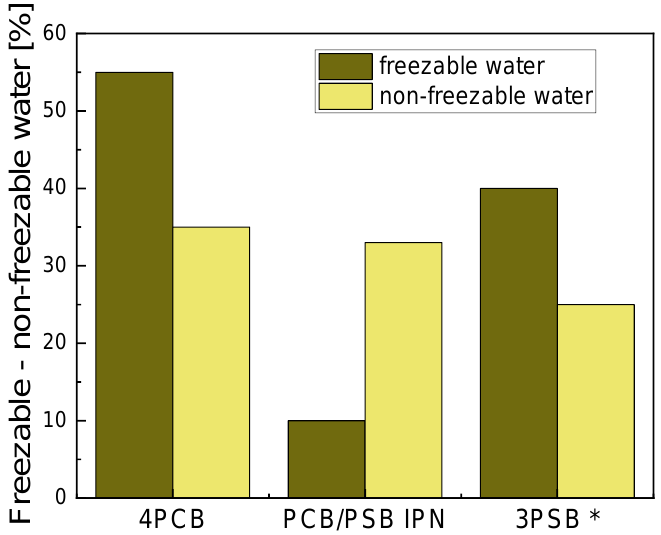
Figure 5. Amount of non-freezable water (NFW) and freezable water (FW) in PCB/PSB IPN hydrogel. For sake of comparison the data for single PSB and PCB networks are also provided [18,19].